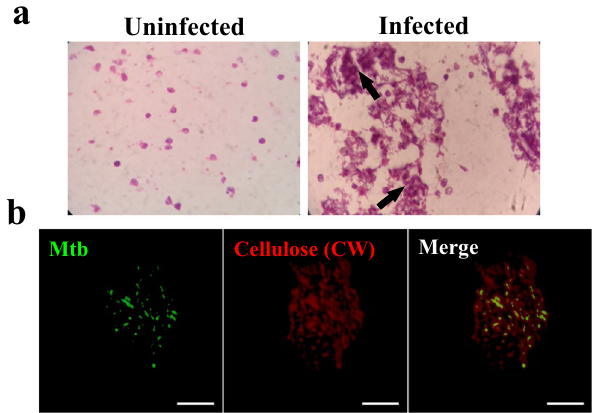
Fig. 4 Mtb forms bio fi lms inside the in vitro granulomas. a Histopathology staining of 5 μ m thick sections of uninfected and Mtb infected PBMCs placed on a collagen based 3D matrix visualized on a compound microscope. b CW and Auramine staining of the granuloma sections suggesting encapsulation of Mtb bacilli within a cellulose-rich extracellular matrix. All data are representative of three independent biological experiments. Scale bars correspond to 10 μ